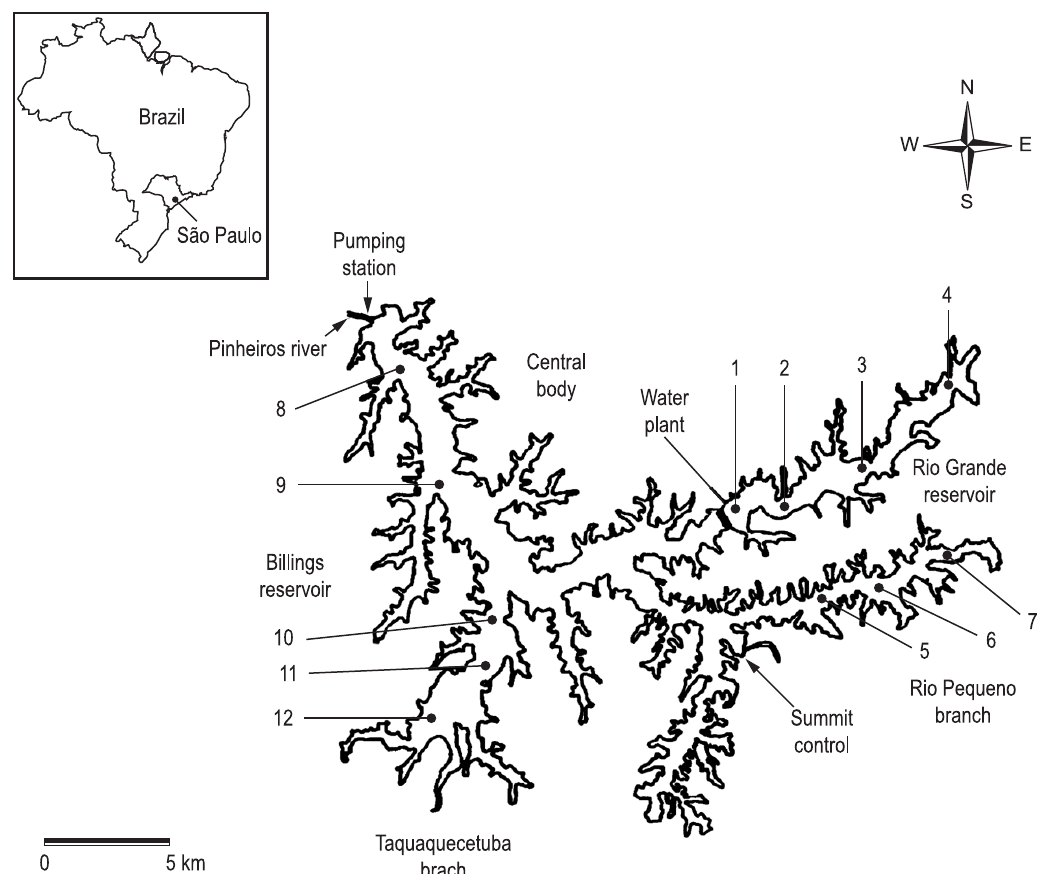
Figure 1. Billings Complex and locations of sampling sites: Rio Grande Reservoir (1-4), Rio Pequeno branch (5-6), Central body (8-9), and Taquacetuba branch (10-12). Adapted from Carvalho et al.